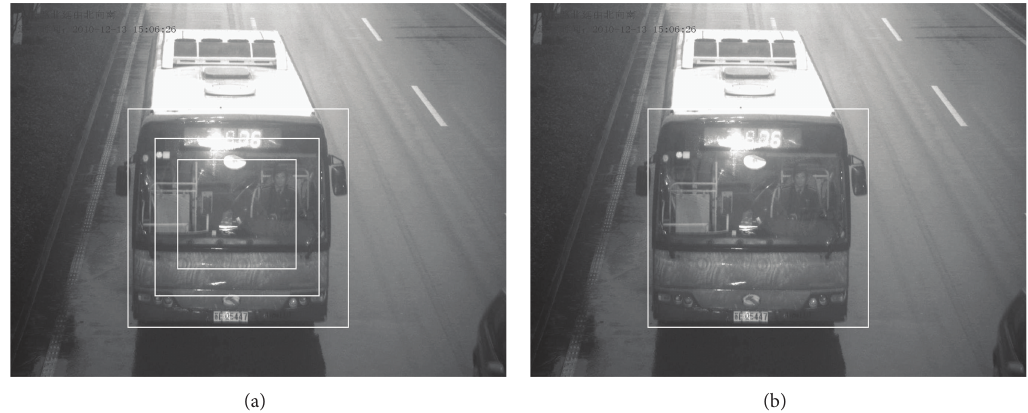
Figure 7: The containment relations for the bounding boxes and the final result from deleting the smaller ones.